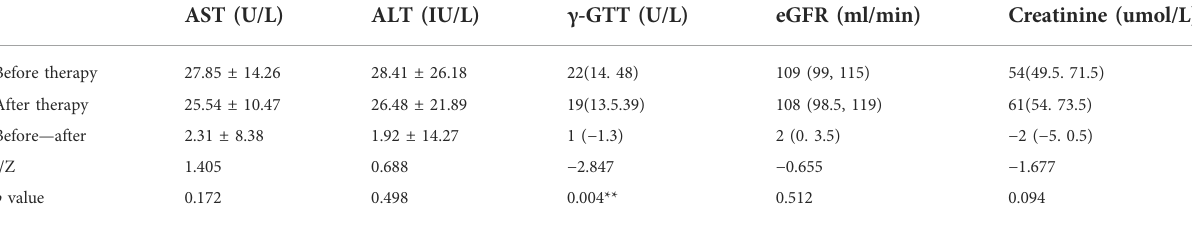
TABLE 9 Liver and kidney function indexes in the PPQH group of SARS-CoV-2-infected patients. AST